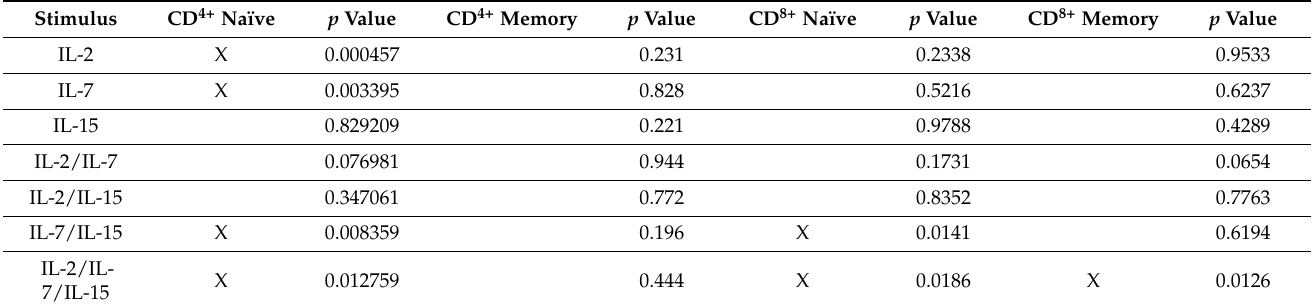
Table 2. p -values of statistical significance for a stimulus on each T cell